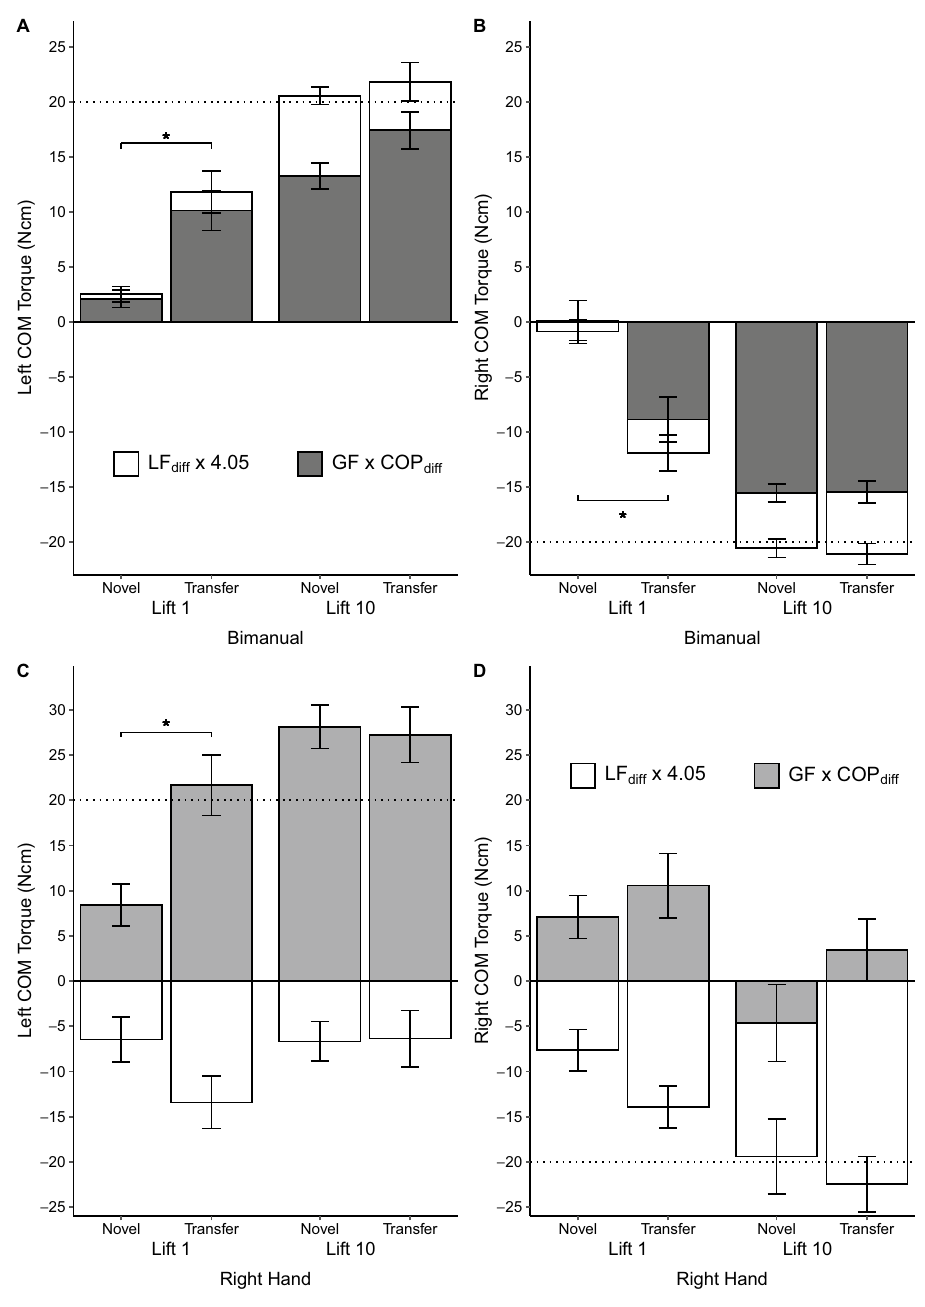
Figure 8. Grasp contribution of torque components to Tcom. ( A , B ) Stacked bar graph showing how LF diff and GF with COP diff affected Tcom for lift 1 and 10 of the novel and transfer conditions for the left and right COM during bimanual grasps. ( C, D ) Stacked bar graph showing how LF diff and GF with COP diff affected Tcom for lift 1 and 10 of the novel and transfer conditions for the left and right COM during right hand grasps. Error bars indicate the standard error of the mean. Horizontal dotted line indicates target Tcom. LF diff did not differ across conditions. * p < .05 for GF × COP diff